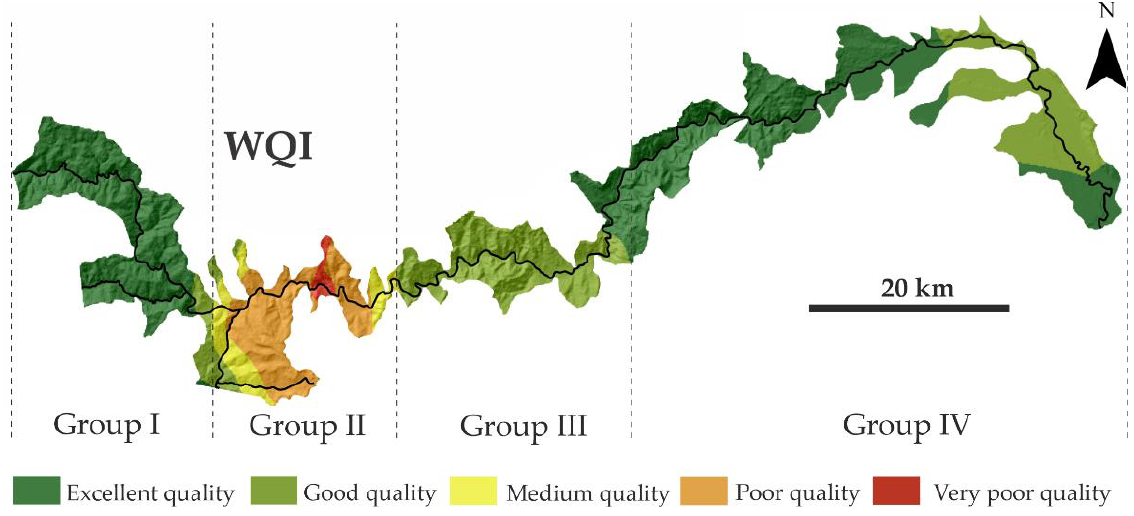
Figure 8. Spatial variation of the water quality index (WQI).